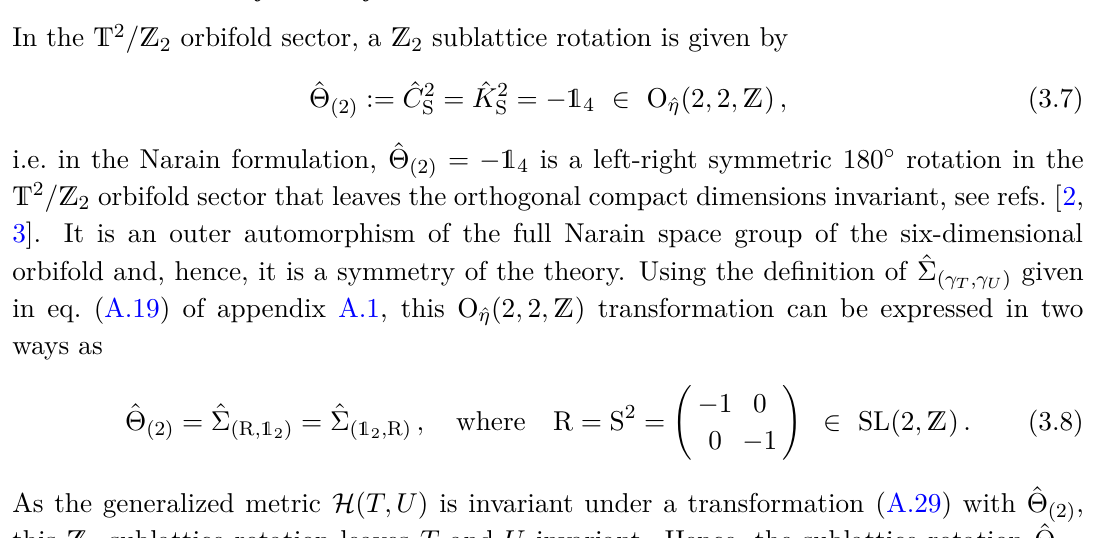
Table 1. All admissible modular weights of massless matter fields Φ resentations under the flavor symmetries and Z R Z R R -charges are normalized to be integer for matter superfields Φ 4 group is [64 , 266] and the modular flavor group is [144 , 115]